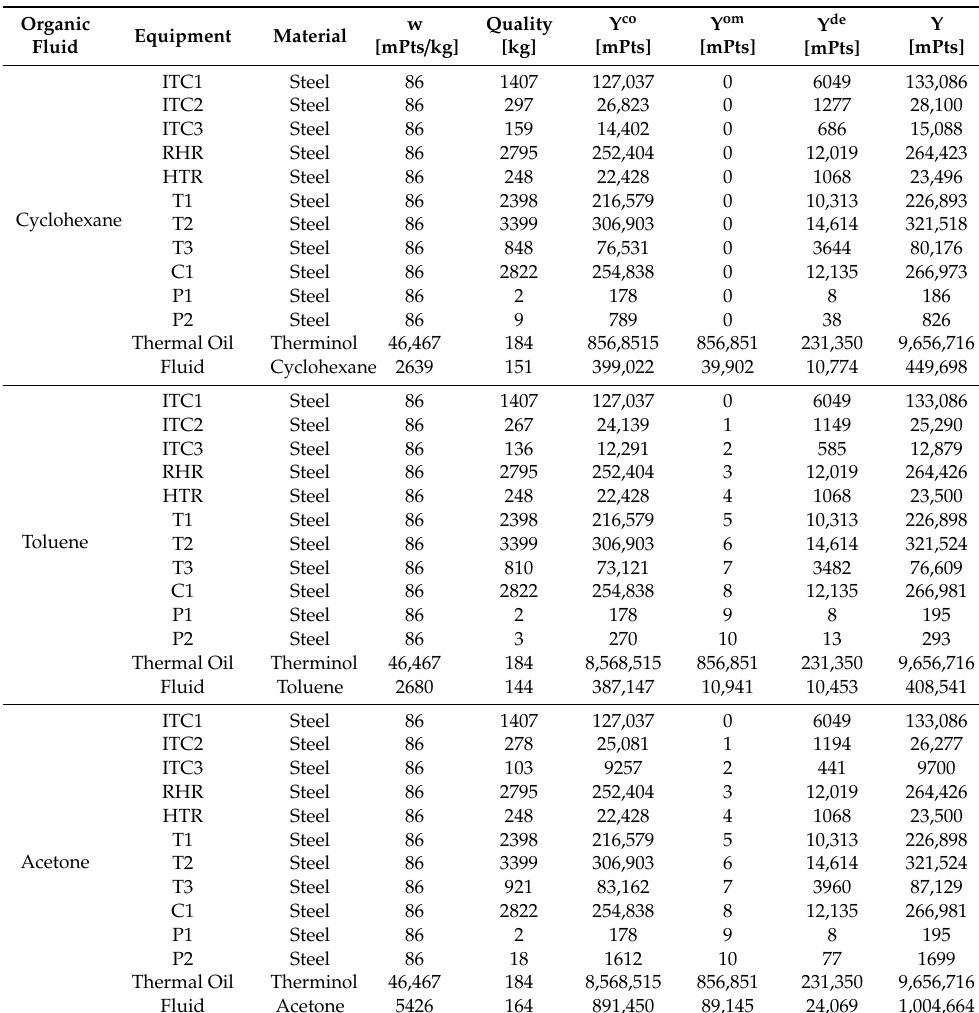
Table 4. Results of Life Cycle Assessment for each component selecting steel as the material. Organic